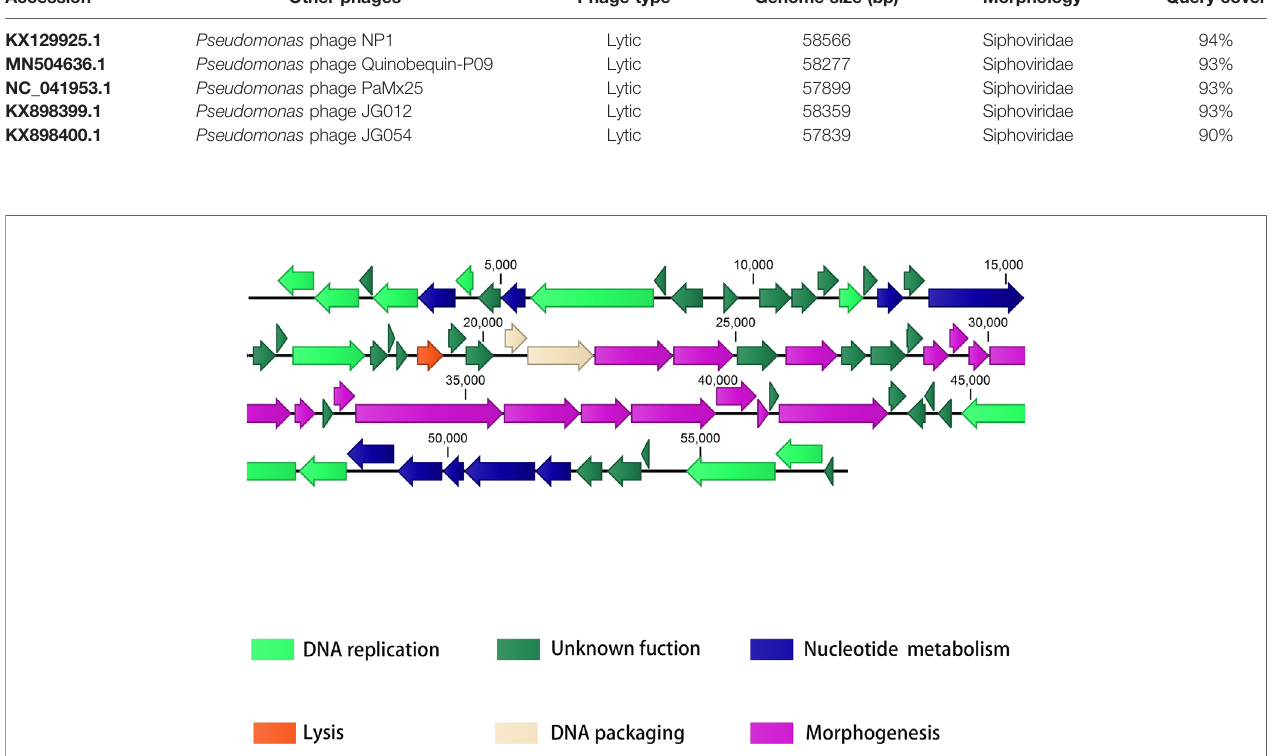
FIGURE 3 | The genome map of PAJD-1. The ORFs in the direction of transcription is shown by arrows. Groups of functional genes are indicated by different colours, including morphogenesis (purple), DNA replication (light green), nucleotide metabolism (blue), lysis (red), DNA packaging (pink), and hypothetical proteins (bottle green) modules.